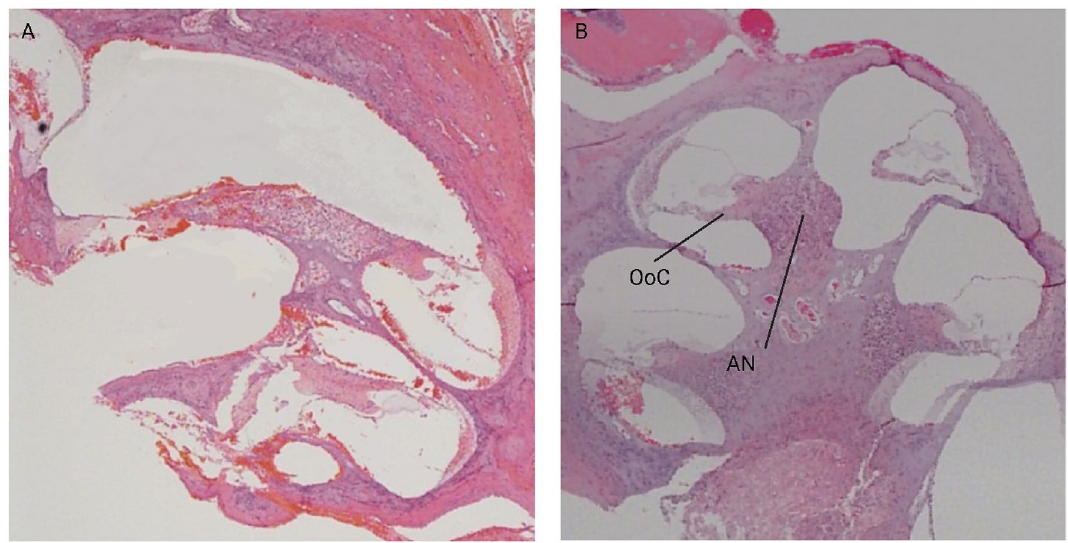
Figure 5. Histology of the cochlea-lesioned ( A ) and non-cochlea-lesioned ( B ) temporal bones, stained with haematoxylin and eosin showing the overall morphology. Auditory nerve (AN), the organ of Corti